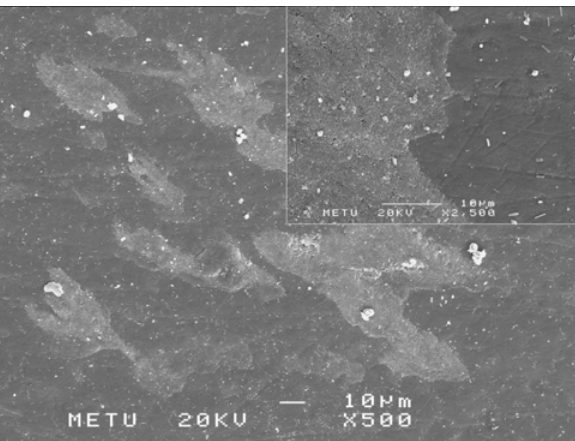
FIGURE 9- SEM analysis of the intact